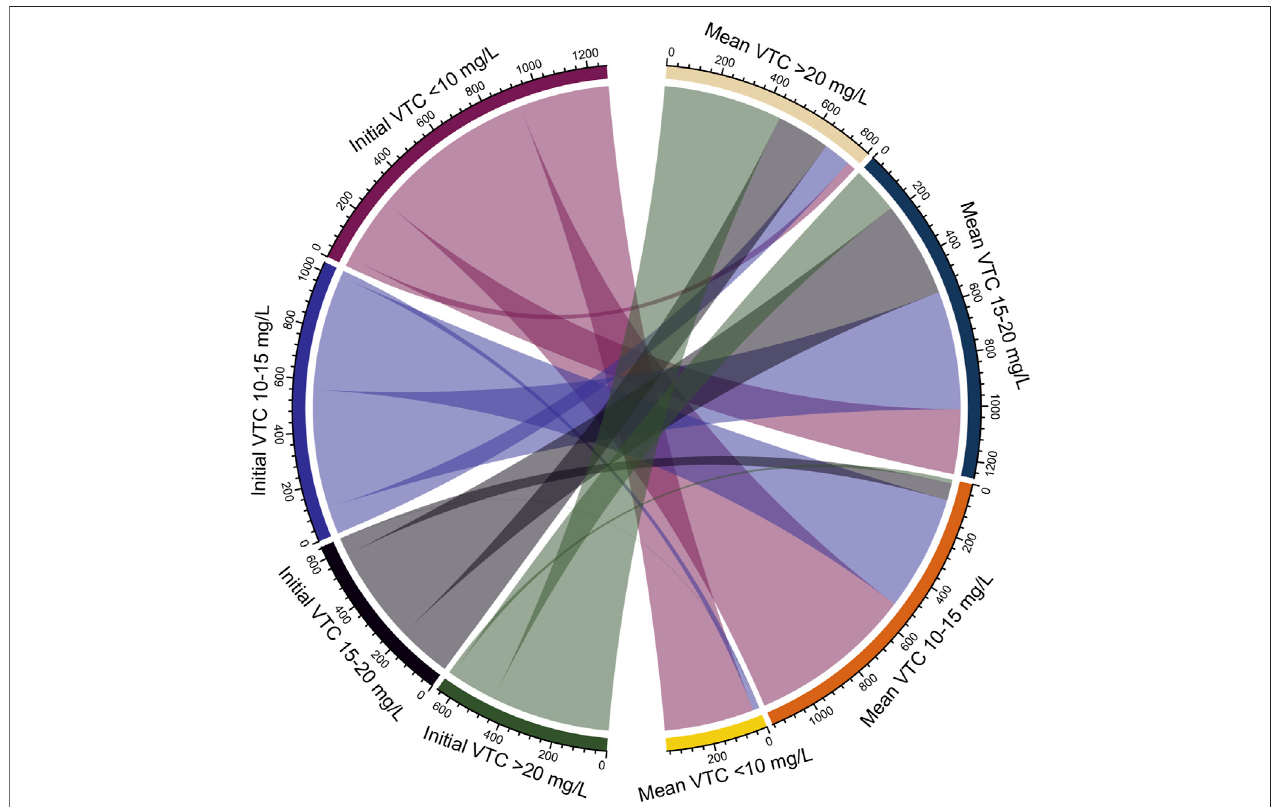
FIGURE 2 | Connection Between the Mean VTC and Initial VTC. A chord diagram presented the difference of the mean VTC with initial VTC for each patient. VTC, vancomycin trough concentration.